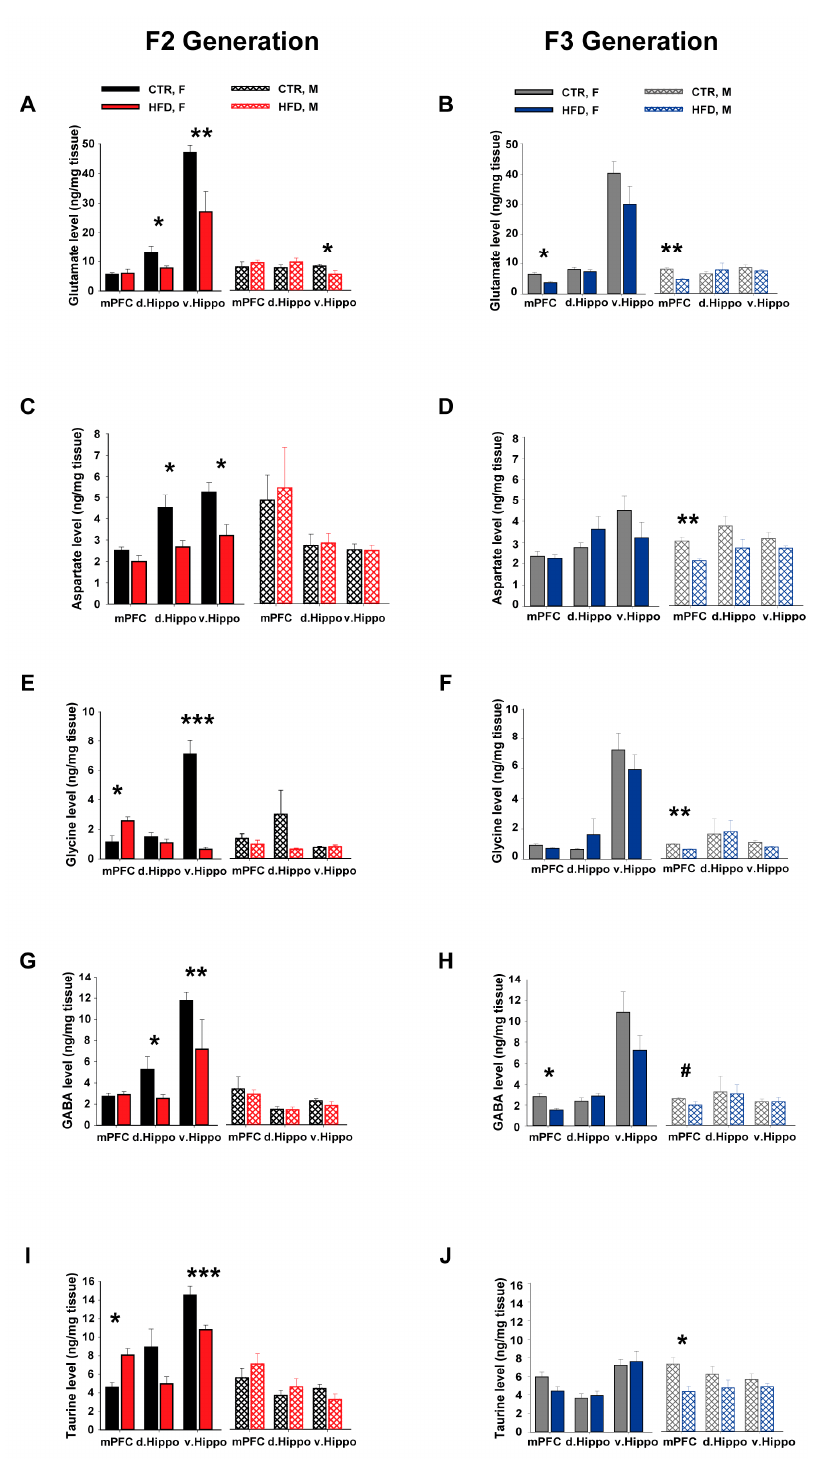
Figure 4. Postmortem neurochemical assessments in the F2 and F3 offspring. Levels of the excitatory amino acids glutamate ( A , B ) and aspartate ( C , D ), as well as the inhibitory amino acids including glycine ( E , F ), GABA ( G , H ), and taurine ( I , J ) were measured by postmortem HPLC in the F2 and F3 offspring. Amino acids were measured in the mPFC, d.Hippo, and v.Hippo and expressed as ng/mg tissue weight. N (F2 CTR) = (8 M, 8 F), N (F2 HFD) = (8 M, 9F), N (F3 CTR) = (8 M, 9F), N (F3 HFD) = (8 M, 8F). All values are means ± SEM. * p < 0.05; ** p < 0.001; *** p < 0.0001. mPFC = medial prefrontal cortex, d.Hippo = dorsal hippocampus, v.Hippo = ventral hippocampus, HFD = high fat diet, CTR = control, F = female, M = male.